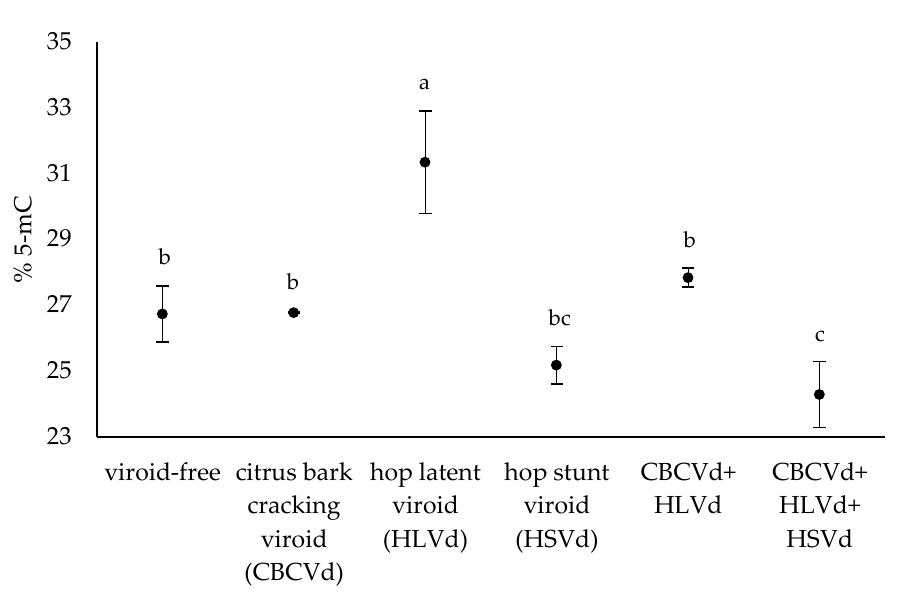
Figure 1. The average % 5-mC in the hop plants tested. The letters indicate statistically significant results ( p -value < 0.05) and the bars show the standard errors.